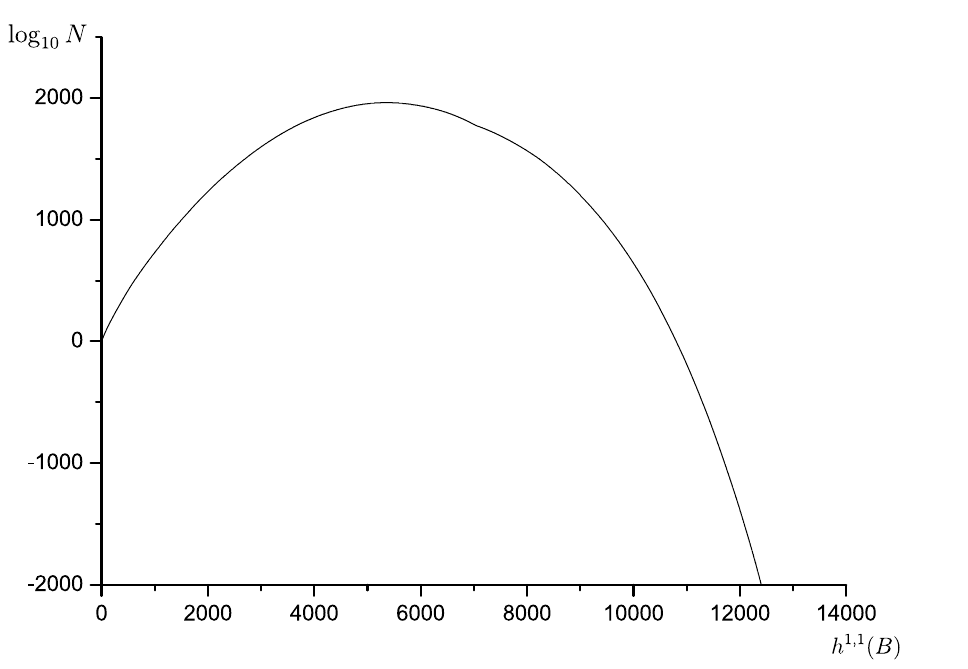
Figure 6 . Logarithm of the estimated number of resolvable bases N nodes as function of h 1 ; 1 ( B ), from blowing up P 3 .